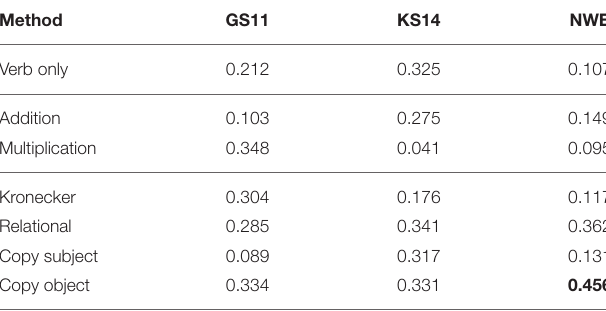
The best performing models are highlighted in